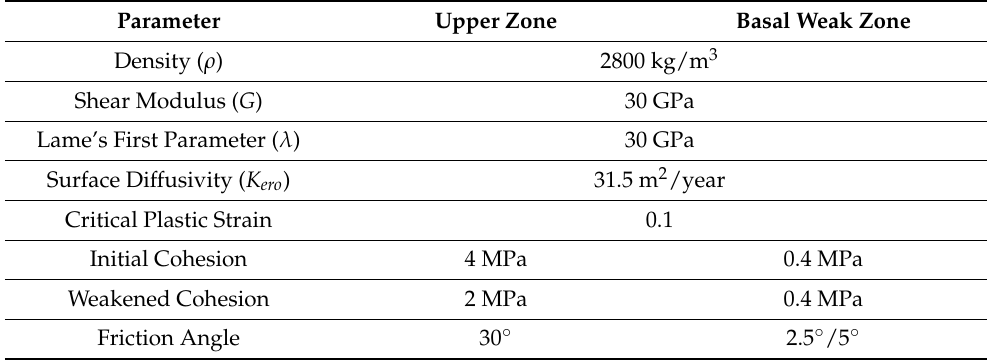
Table 1. Mechanical properties of